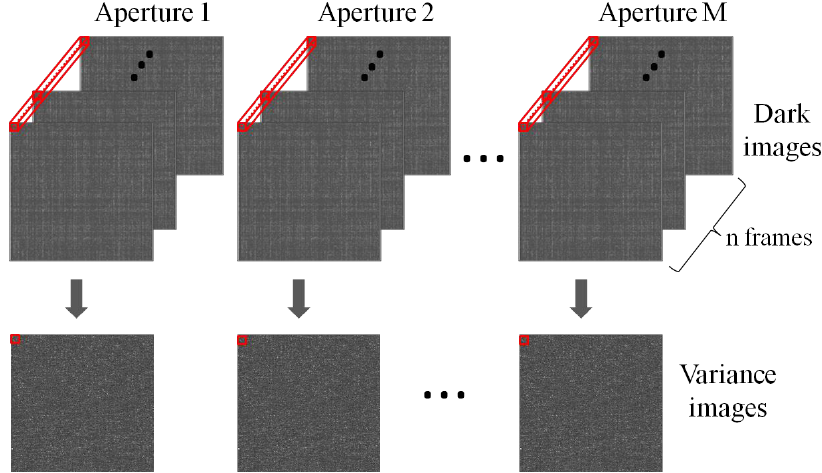
Figure 3. Variance calculations in multi-aperture camera.